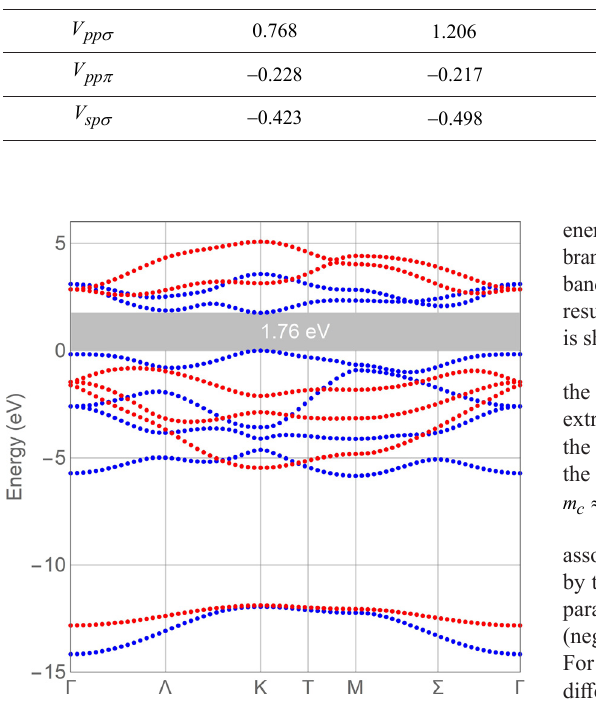
Figure 3. The electronic structure of the MoS calculations. Blue (red) dots are for Bloch states that are symmetric (antisymmetric) with respect to the Mo plane.